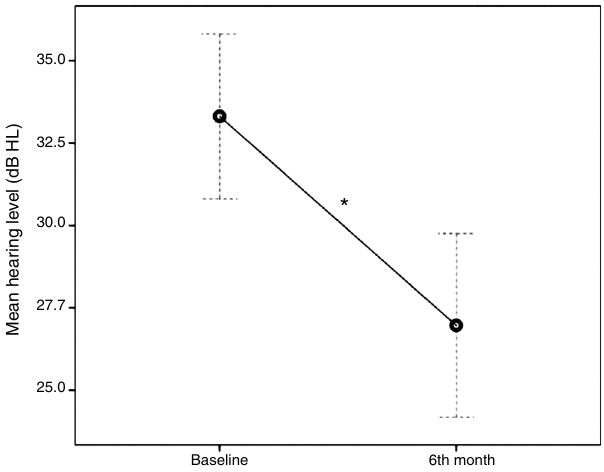
Changes in the mean hearing levels at baseline and six months after treatment. Error bars represent 95% confidence interval. * p ≤ 0.05 is statistically